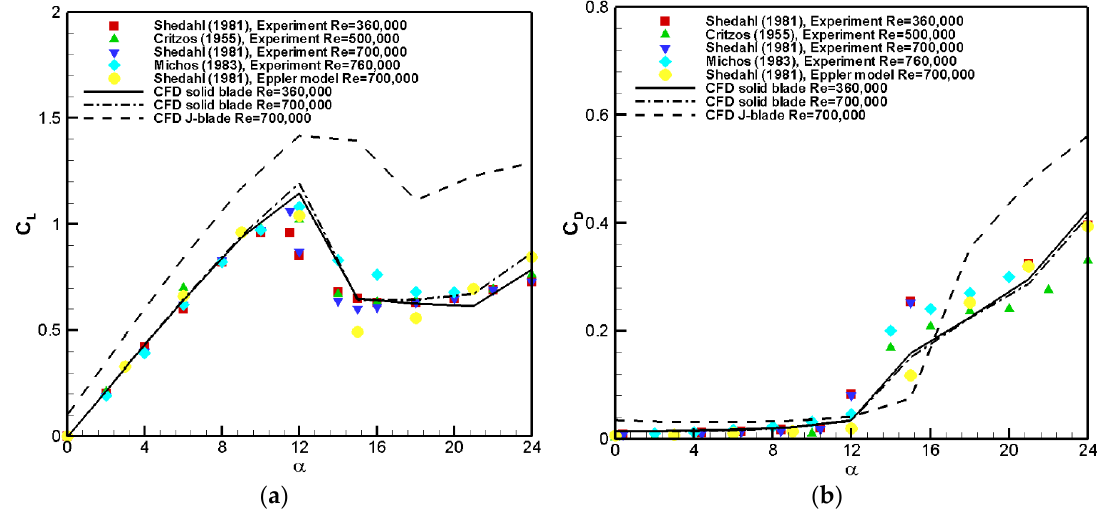
Figure 3. ( a ) Lift and ( b ) drag coefficients on a NACA 0012 airfoil and a J-shaped airfoil based on NACA 0012, compared with empirical measurements and other models from the literature [21–23].